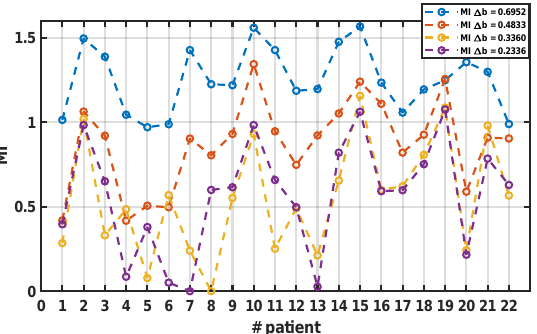
Figure 8. Estimated MI for cardiac signals in patient database for different bin widths.